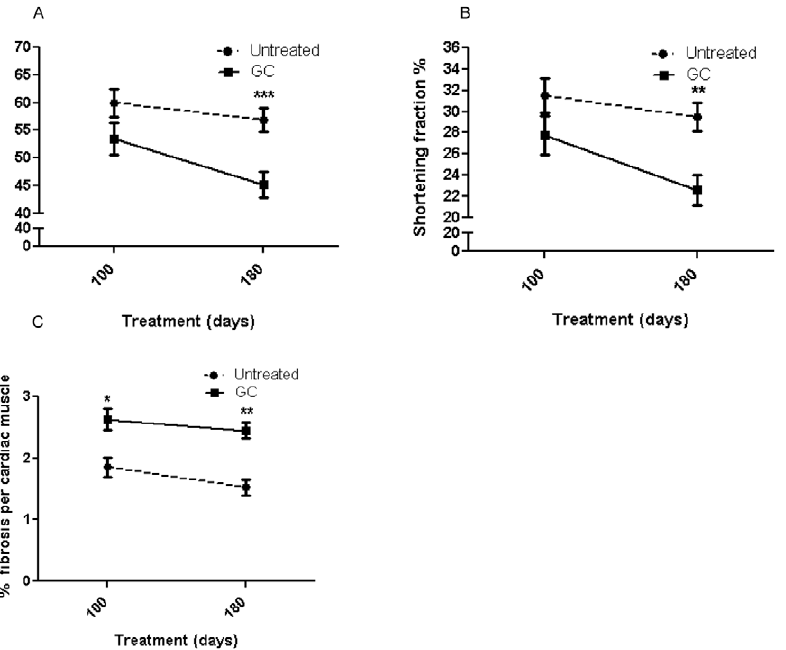
Figure 3. Effect of treatments on cardiac function and fibrosis. ( A ) Ejection fraction (%) and ( B ) shortening fraction (%) were assessed by echocardiography in mice who received no treatment (N=30, 21) or GC treatment (N=25, 19) for 100 or 180 days, respectively. ( C ) Sirius Red staining of formalin-fixed heart sections was used to estimate collagen content. mdx mice received no treatment (N=12, 13) or GC treatment (N=11, 14) for 100 or 180 days, respectively. Error bars indicate mean + /- SEM. **p = , 0.01 and ***p = , 0.001.